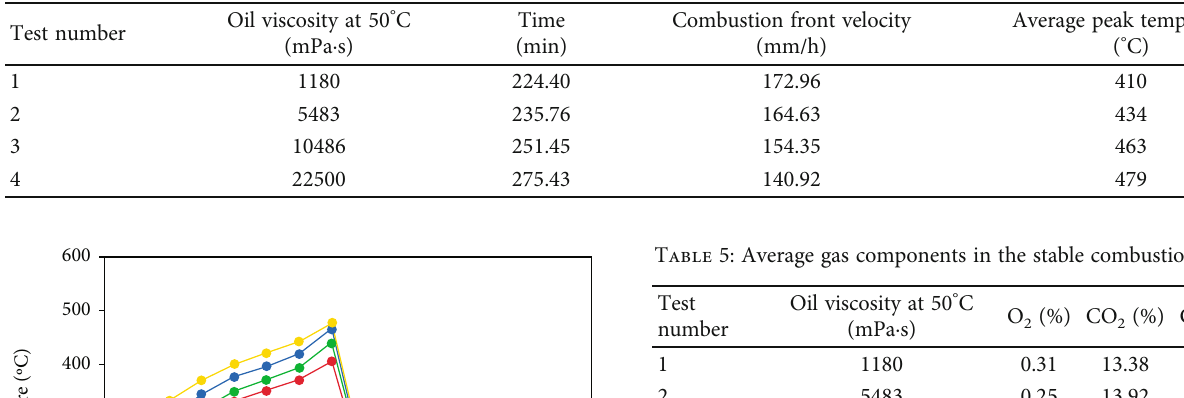
Table 4: The combustion parameters during steady combustion.